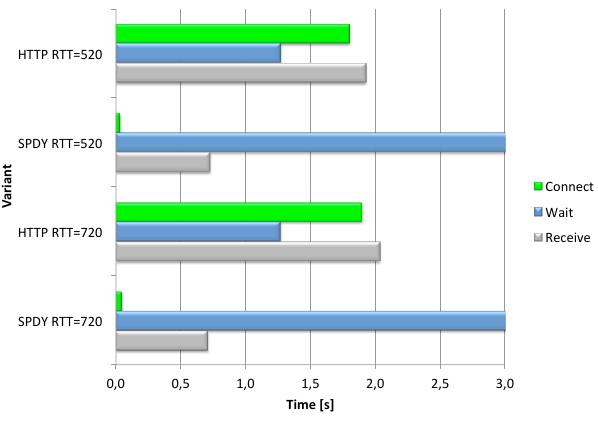
Figure 5. Breakdown of the average OLT on the overall dataset.